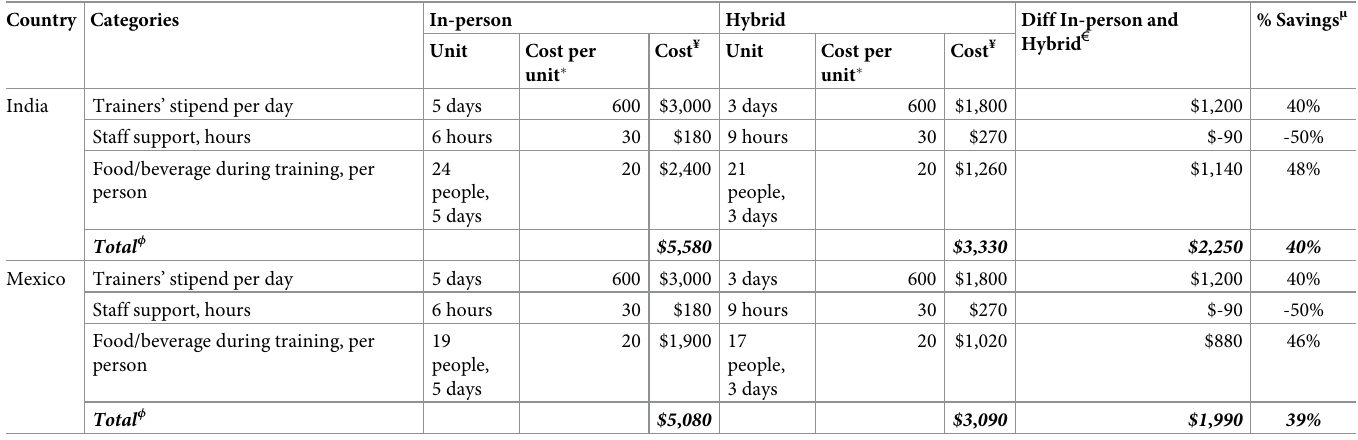
Table 3. Training interventions’